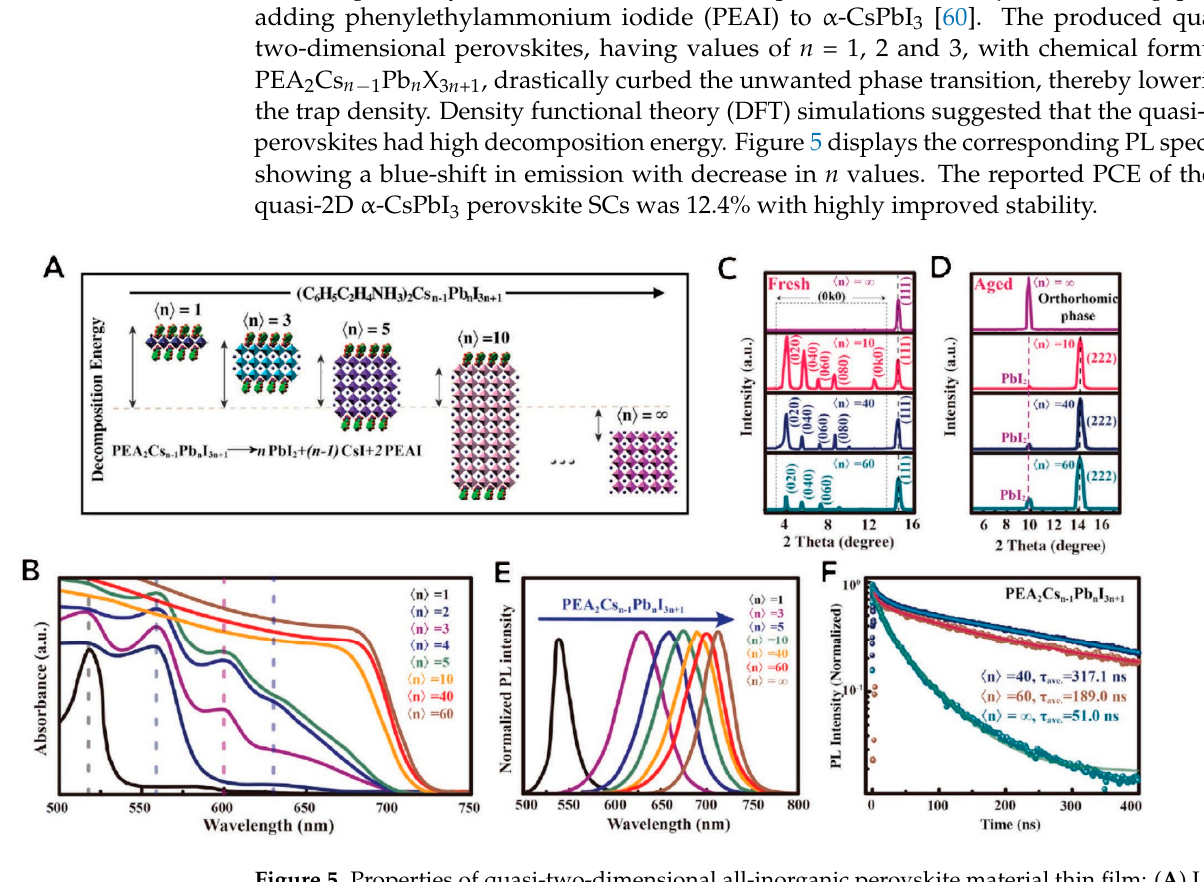
Figure 5. Properties of quasi ‐ two ‐ dimensional all ‐ inorganic perovskite material thin film: ( A ) Unit structure of cell of PEA 2 Cs n − 1 Pb n X 3 n +1 and its decompositional energetics employing first principles of density functional theory simulation having various values of 𝑛 ; ( B ) Ultraviolet–vis absorbance spectra having various values of 𝑛 ; ( C ) Low diffraction angle zone of XRD spectra of powdered perovskite; ( D ) XRD pattern of a chosen zone after aging of perovskite thin films; ( E ) normalized PL spectra, and ( F ) Time ‐ resolved PL decay. Adapted with permission from [60].